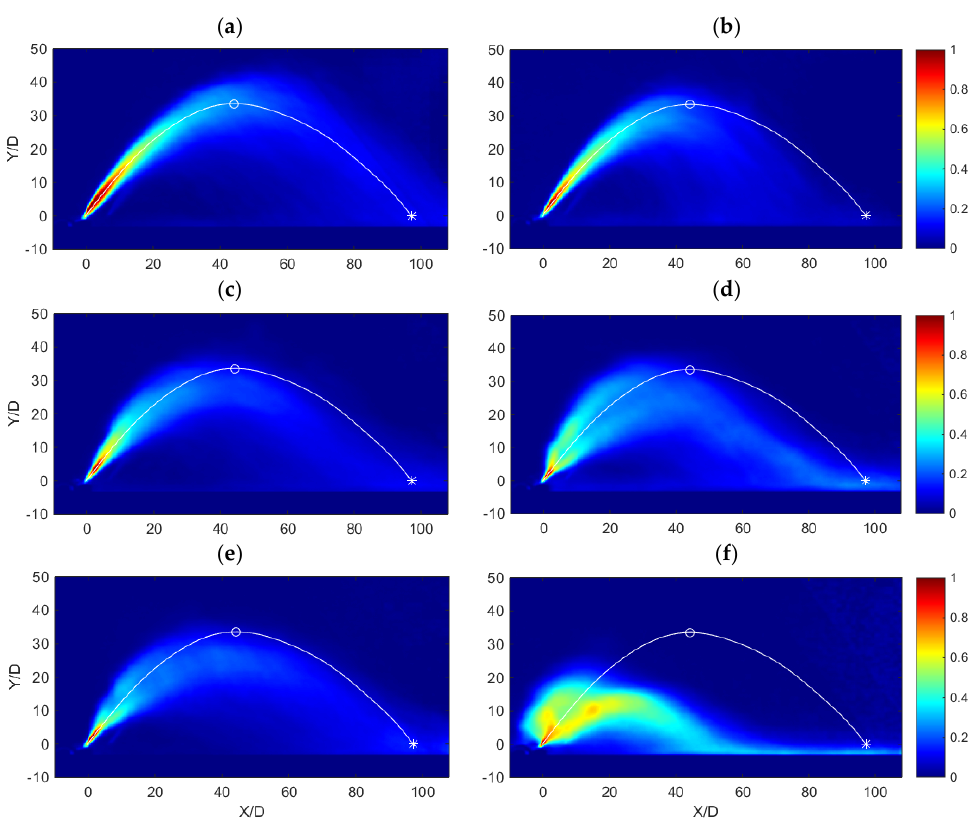
Figure 11. Non-dimensional mean concentration fields for an NBJ with Fr = 28.0 released into a receiving body affected by regular waves with T = 0.0 s and A = 0.0 mm (stagnant case, a ), T = 0.5 s and A = 5.0 mm ( b ), T = 1.0 s and A = 5.0 mm ( c ), T = 1.0 s and A = 12.5 mm ( d ), T = 1.5 s and A = 5.0 mm ( e ) and T = 1.5 s and A = 12.5 mm ( f ), with the stagnant case jet axis; the maximum uncertainty in the mean concentration measurement is ±4.41% in (a), ±4.52% in (b), ±4.16% in (c), ±4.38% in (d), ±4.28% in (e), ±4.31% in (f).